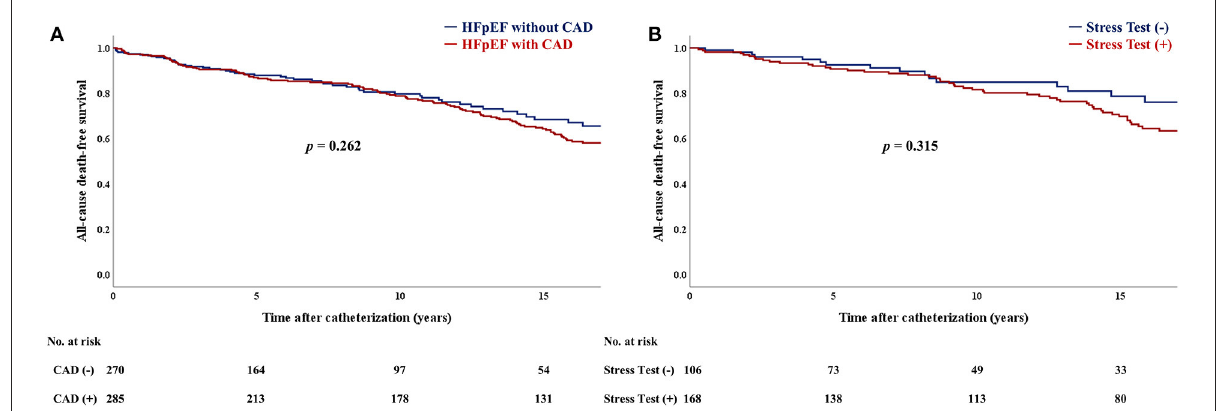
FIGURE4 Kaplan–Meier curves for (A) all-cause mortality between CAD and no-CAD groups. Kaplan–Meier curves for (B) all-cause mortality between stress test ( + ) and (-) groups. CAD, coronary artery disease; HFpEF, heart failure with preserved ejection